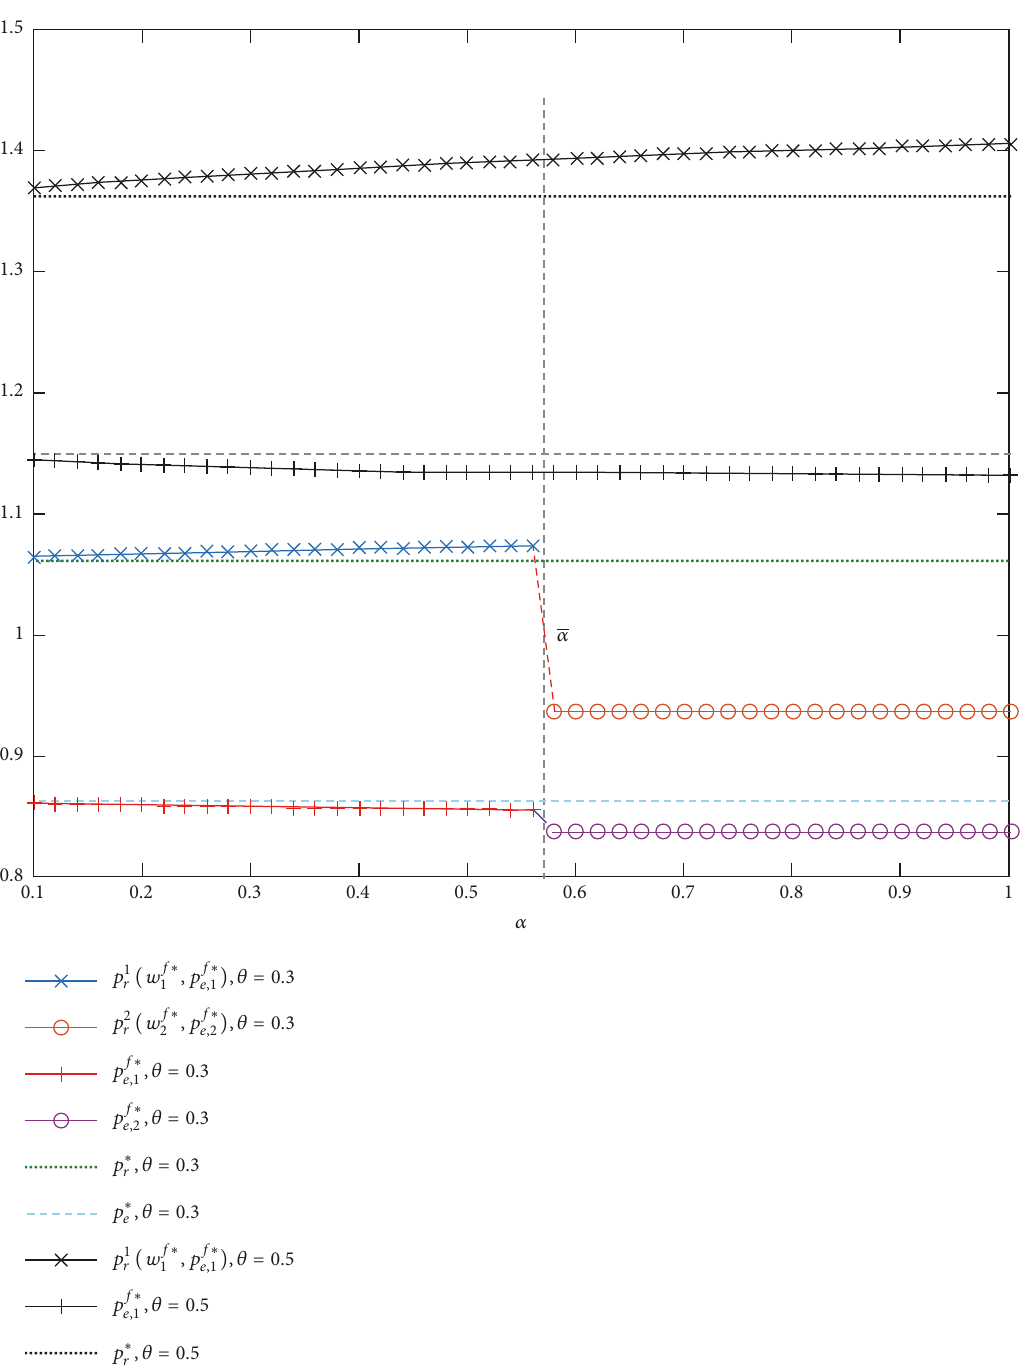
Figure 3: Impact of 𝜃 and 𝛼 on online and offline